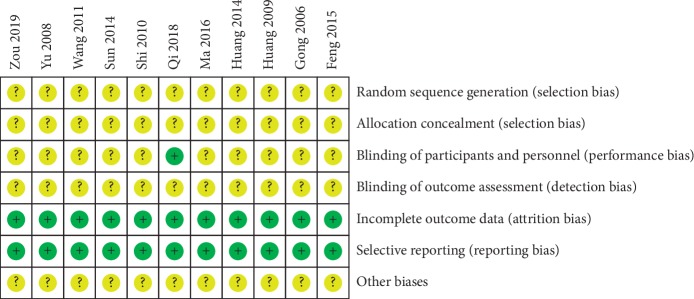
Risk of bias graph.